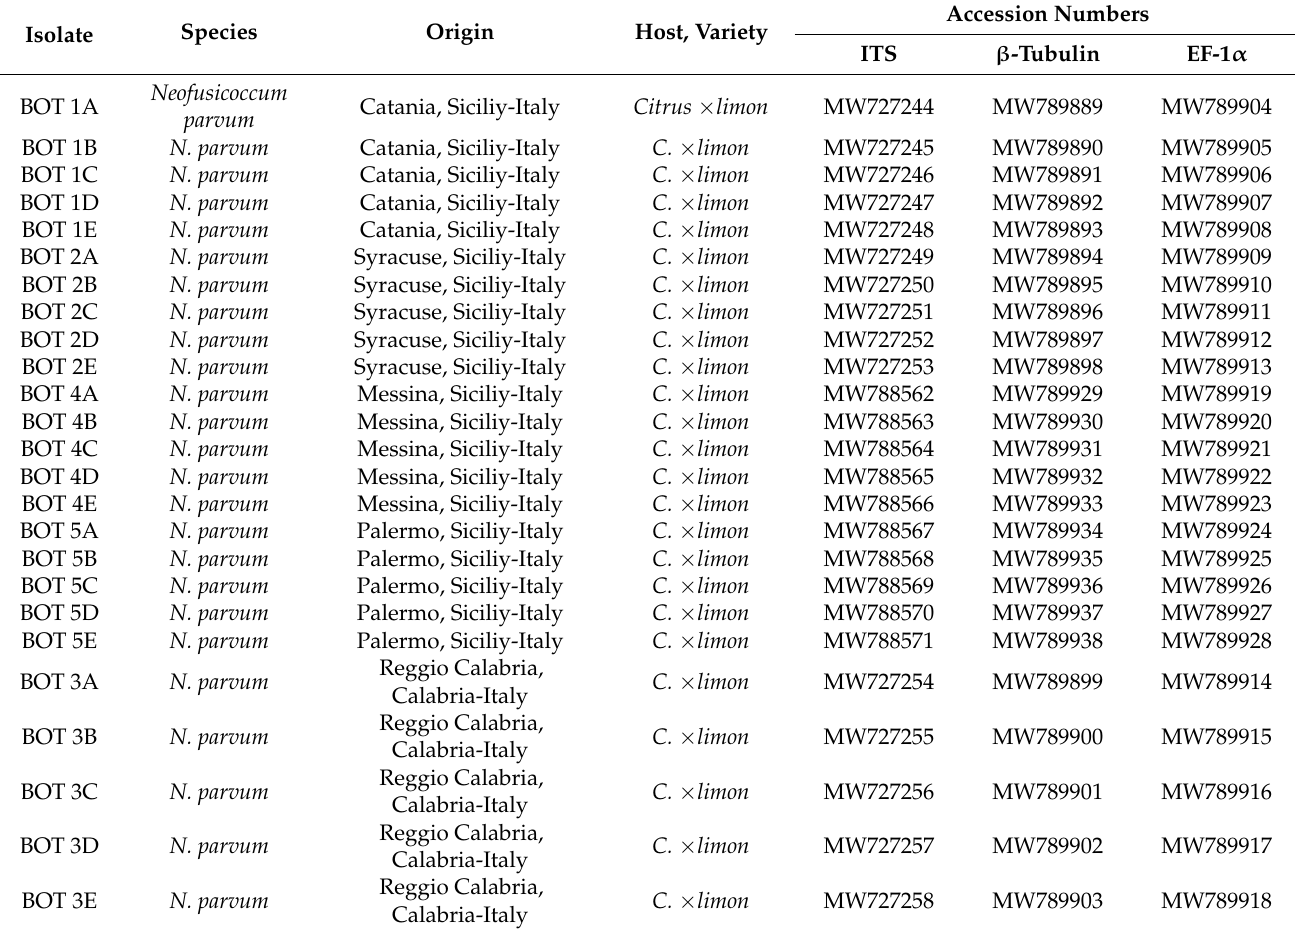
Table 1. Identity of the Neofusicoccum parvum isolates sourced from gummy cankers of lemon ( Citrus × limon ) trees in southern Italy characterized in this study, and corresponding GenBank accession numbers.